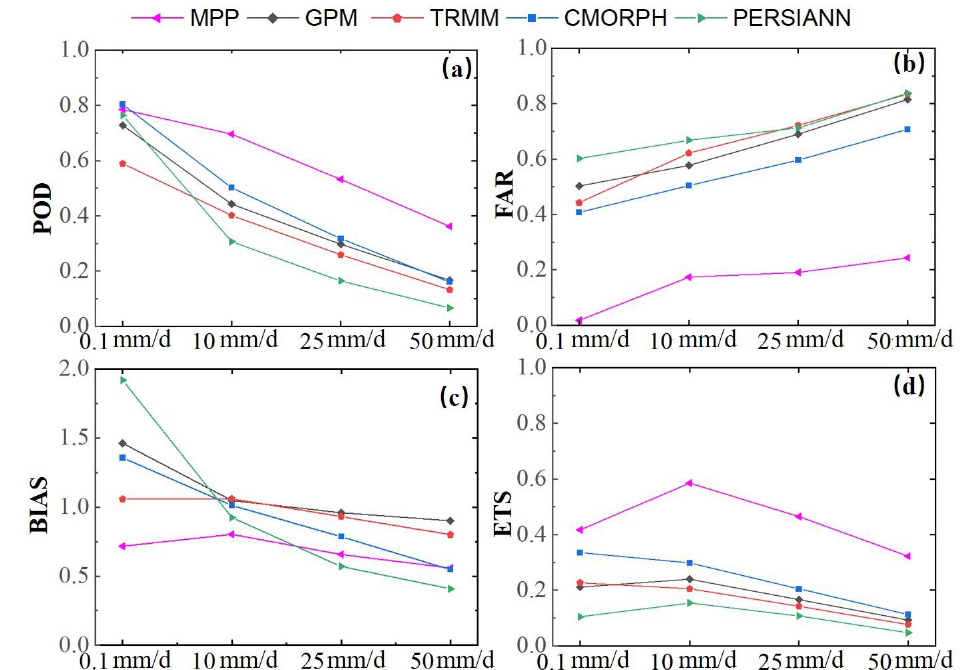
Figure 10. Evaluation statistics for categorical indices (( a ) POD, ( b ) FAR, ( c ) BIAS, and ( d ) ETS) at four precipitation intensity (0.1, 10, 25, and 50 mm/d) classes.